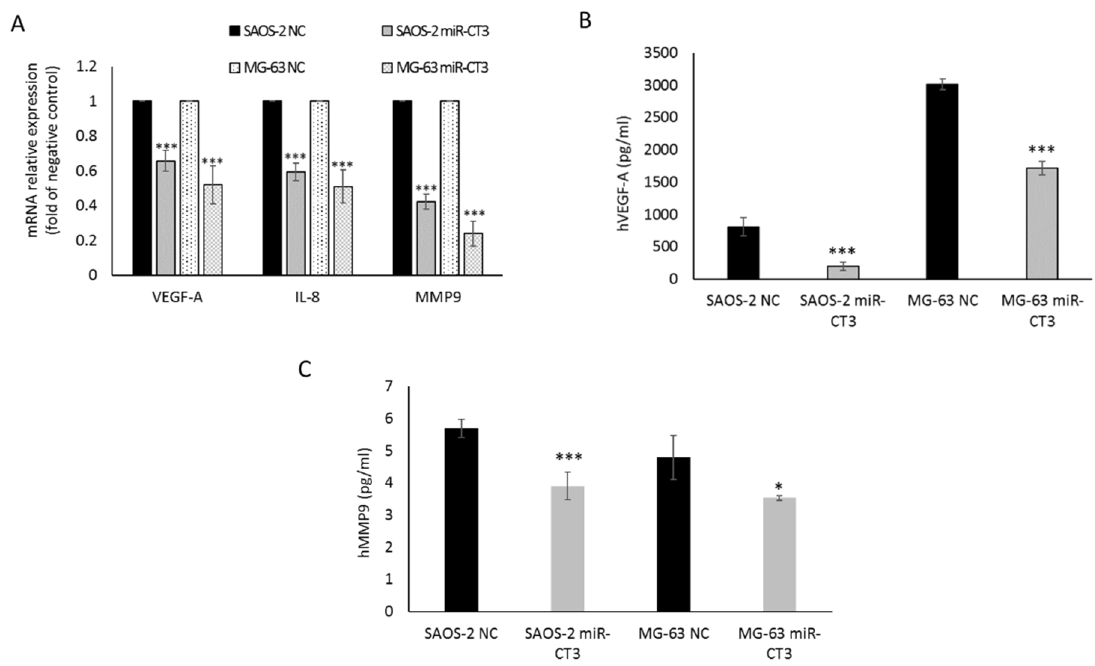
Figure 2. MiR-CT3 over-expression decreases expression of angiogenic and invasive markers. ( A ) Barplot of mRNA relative expression as fold of negative control (NC) of VEGF-A, IL-8 and MMP9 in SAOS-2 and MG-63 cells transfected with miR-CT3 mimics and NC. ( B ) Barplot of ELISA assay of human VEGF-A protein levels in conditioned medium of SAOS-2 and MG-63 cells transfected with miR-CT3 mimics and NC. ( C ) Barplot of ELISA assay of human MMP9 protein levels in conditioned medium of SAOS-2 and MG-63 cells transfected with miR-CT3 mimics and NC. (Mean ± SD, n = 3 triplicate; * p < 0.05; *** p < 0.0005).